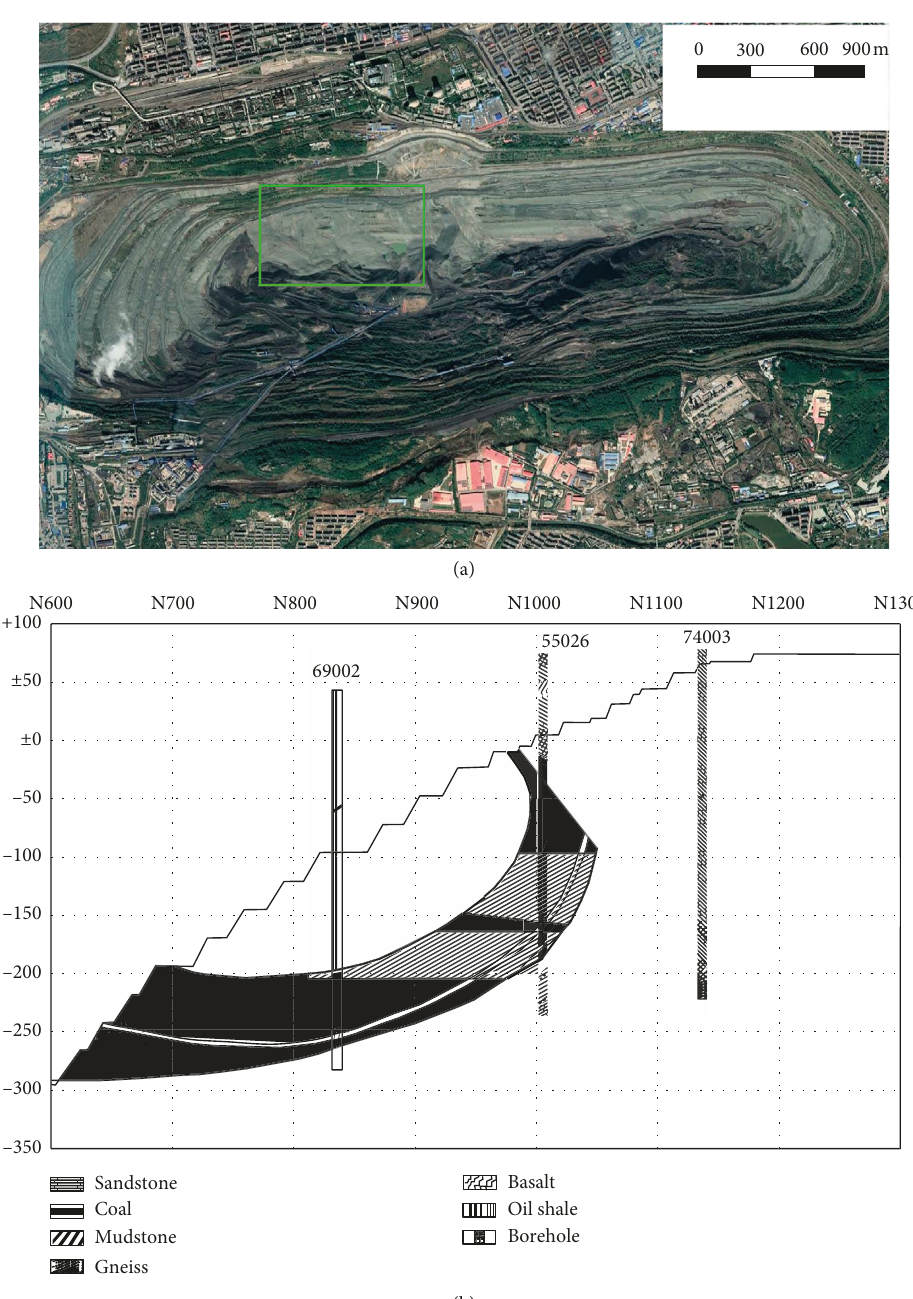
Figure 4: Layout of the Fushun West Open-Pit Mine and the northern part of the western slope in the geological section map: (a) Fushun West Open-Pit Mine; (b) geological section